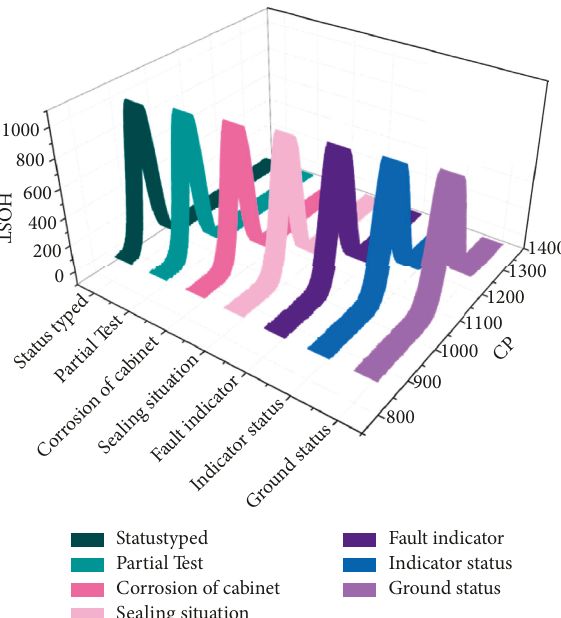
Figure 6: Matching data distribution diagram of different circuit transmission data